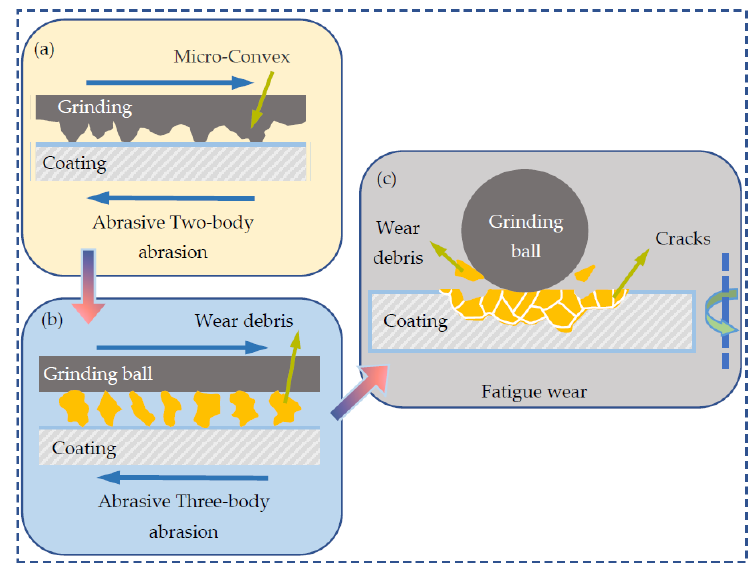
Figure 14. Schematic diagram of wear mechanism transformation of laser cladding ceramic coating: ( a ) Abrasive two-body wear, ( b ) Abrasive three-body wear, ( c ) Fatigue wear.